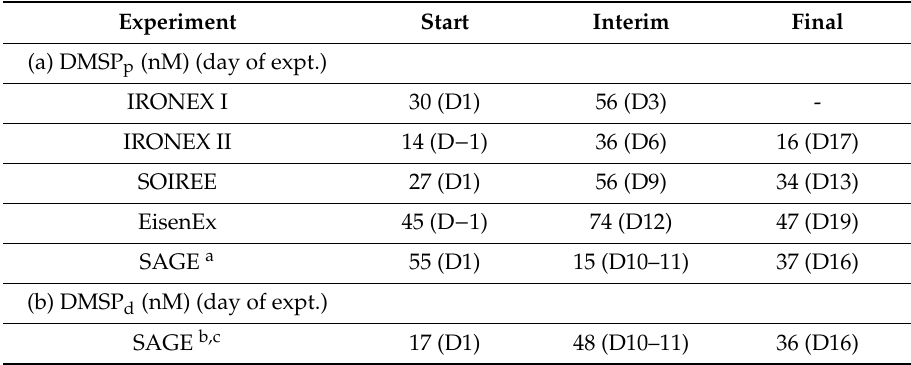
Table 5. Comparison of SAGE DMSP p and DMSP d concentrations with several previous iron enrichment